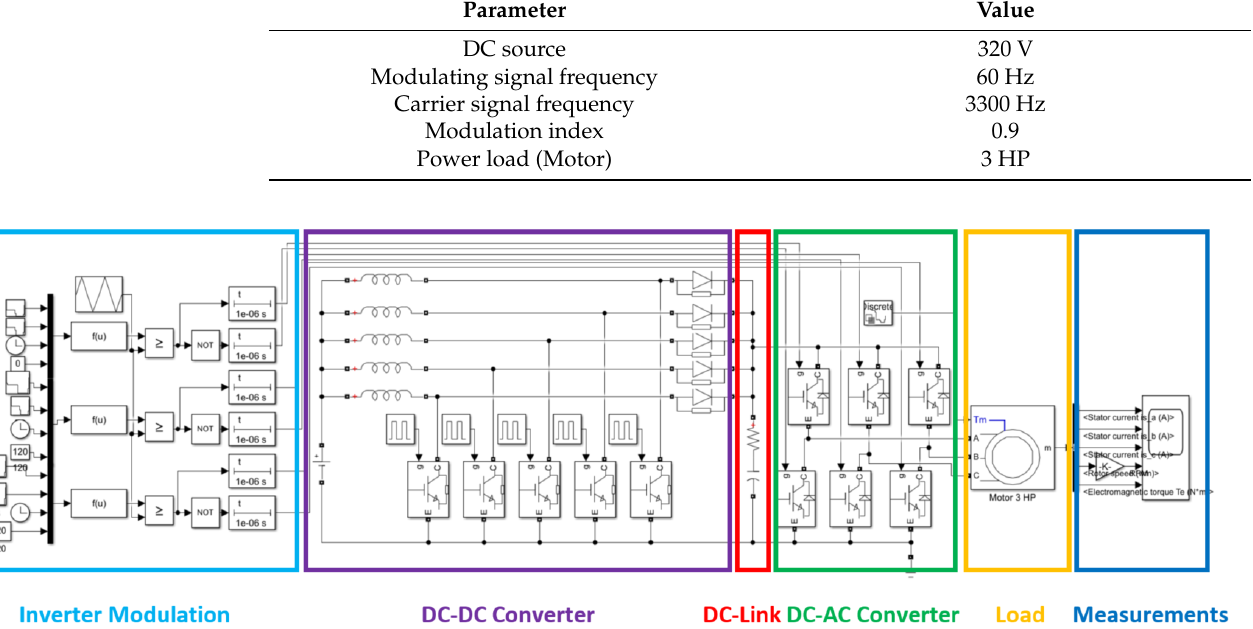
Figure 11. Schematic system diagram.